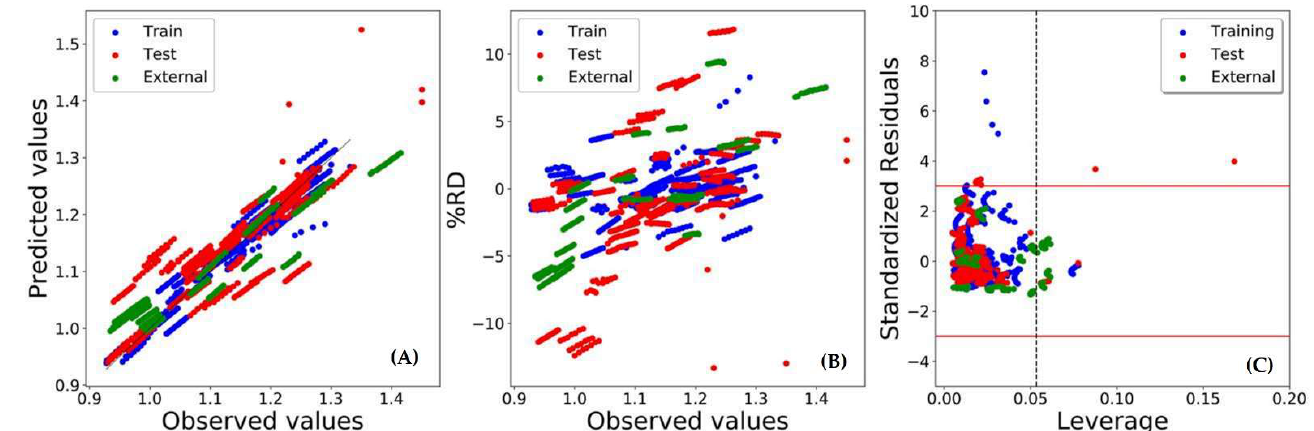
Figure 7. Plots for MO59 model against training, test and external validation sets: ( A ) observed vs. predicted values, ( B ) %RD vs. observed values, and ( C ) William’s plot.